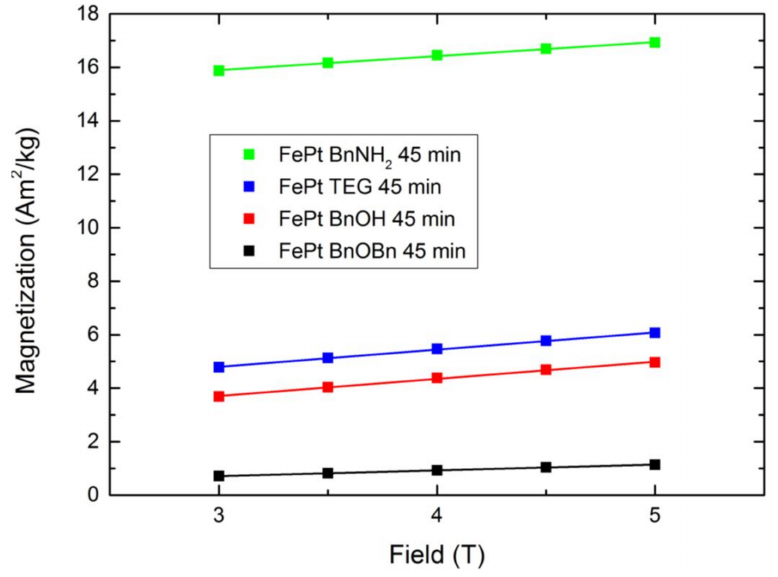
Figure A6. SQUID measurements of the final fcc-FePt nanoparticles of all